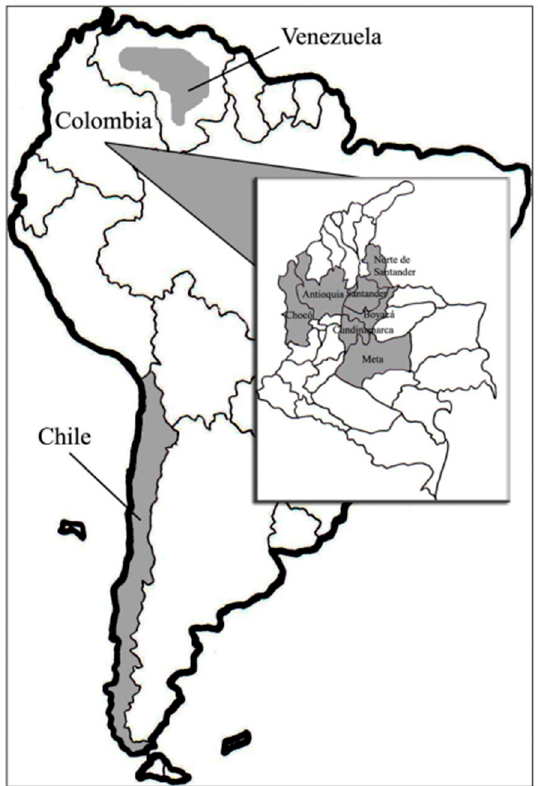
Figure 6. Jejeo distribution in South-American Spanish (adapted from Rodríguez Prieto 2014). In northern Mexico, in Chihuahua, syllable initial /s/ aspiration occurs in varieties spoken in rural areas by speakers with relatively little schooling, often labeled as ranchero talk. It is not clear whether this is a case of stable variation or of ongoing change (see Brown and Cacoullos 2002; L ó pez Ch á vez 1977). In addition to Chihuahuan Spanish, onset /s/ weakening has also been attested in New Mexico and Southern Colorado in the Southwestern United States (Brown